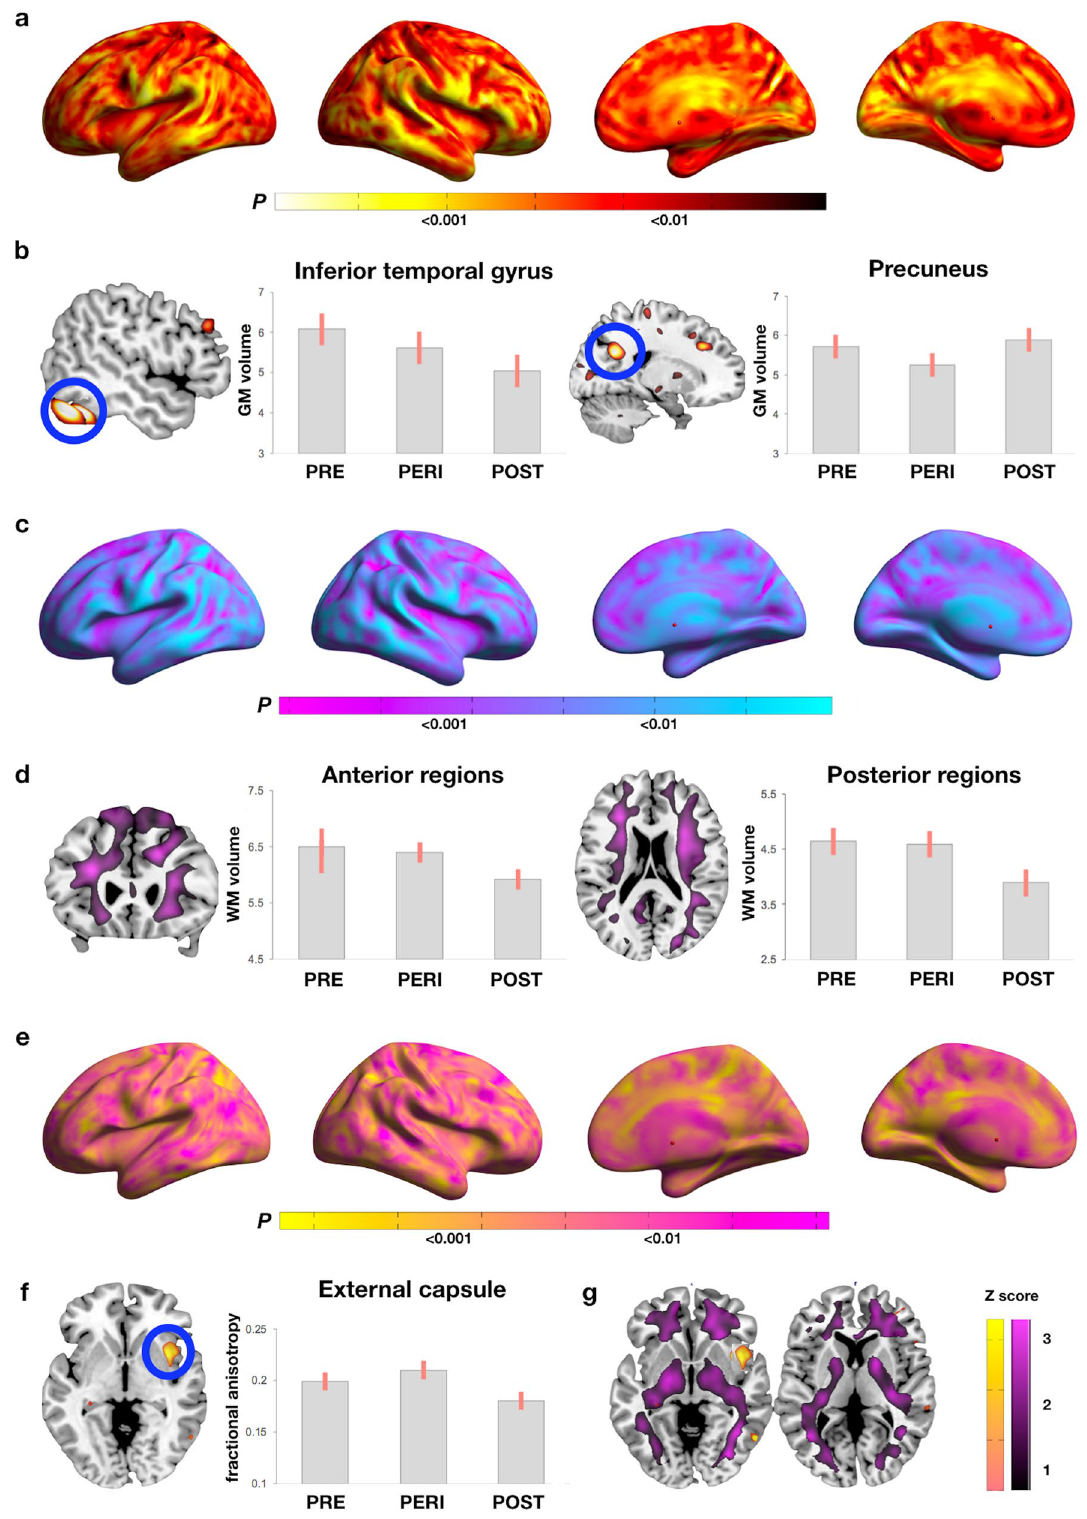
Figure 1. Structural biomarker differences between menopausal groups. ( a ) Surface maps of regional GMV differences. ( b ) MRI slice overlays and plots representing GMV in temporal and precuneus clusters. ( c ) Surface maps of regional WMV differences. ( d ) MRI slice overlays and plots representing WMV in anterior and posterior areas averaged between hemispheres. ( e ) Surface maps of regional FA differences. ( f ) MRI slice overlays and plots representing FA in external capsule. ( g) Slice overlays depicting lack of overlap between WMV (purple) and FA (yellow) effects. In ( a , c , e ), SPMs are represented on modality-specific color-coded scales with corresponding P values. In ( g ), Z scores are reported in lieu of p values to enable multi-modality comparison. In ( b , d ), values are mean (SE). Results are adjusted by age and total intracranial volume. Abbreviations FA, fractional anisotropy; GMV, gray matter volume; PERI, peri- menopause; POST, post-menopause; PRE, pre-menopause; SPMs, statistical parametric maps; WMV, white matter